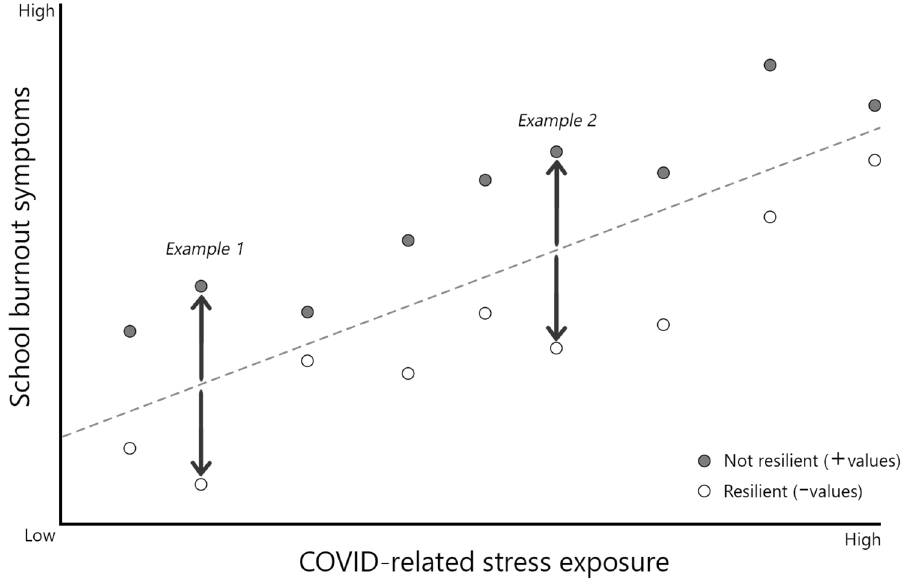
Figure 2. Explanation of resilience variable. Note. Resilience is defined as residuals of the regression between school burnout symptoms and COVID-related stress exposure (observed [dots]—predicted value [regression line]), depicted here as the distance between the regression line and observed values. This is a normative modelling method, as it inherently corrects for individual differences in stressor exposure 17 , which is demonstrated with examples 1 and 2 that have identical residuals. Negative values (open circles) are resilient students, as they maintain better school-related mental health (lower school burnout symptoms) than one would predict based on their level of COVID-related stress exposure.